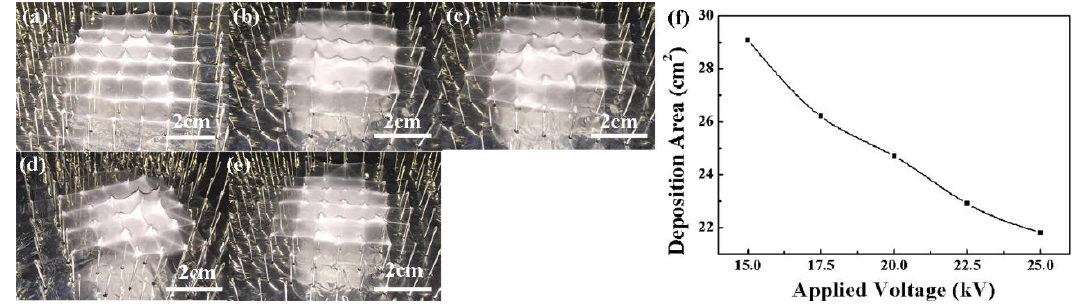
Figure 7. Effect of applied voltages on the printed 3D nanofibrous structures. ( a ) 15 kV; ( b ) 17.5 kV; ( c ) 20 kV; ( d ) 22.5 kV; ( e ) 25 kV; ( f ) relationship between deposition area and applied voltage. The probe height, probe interval, and flow rate were 20 mm, 10 mm, and 300 μL/ h, respectively.